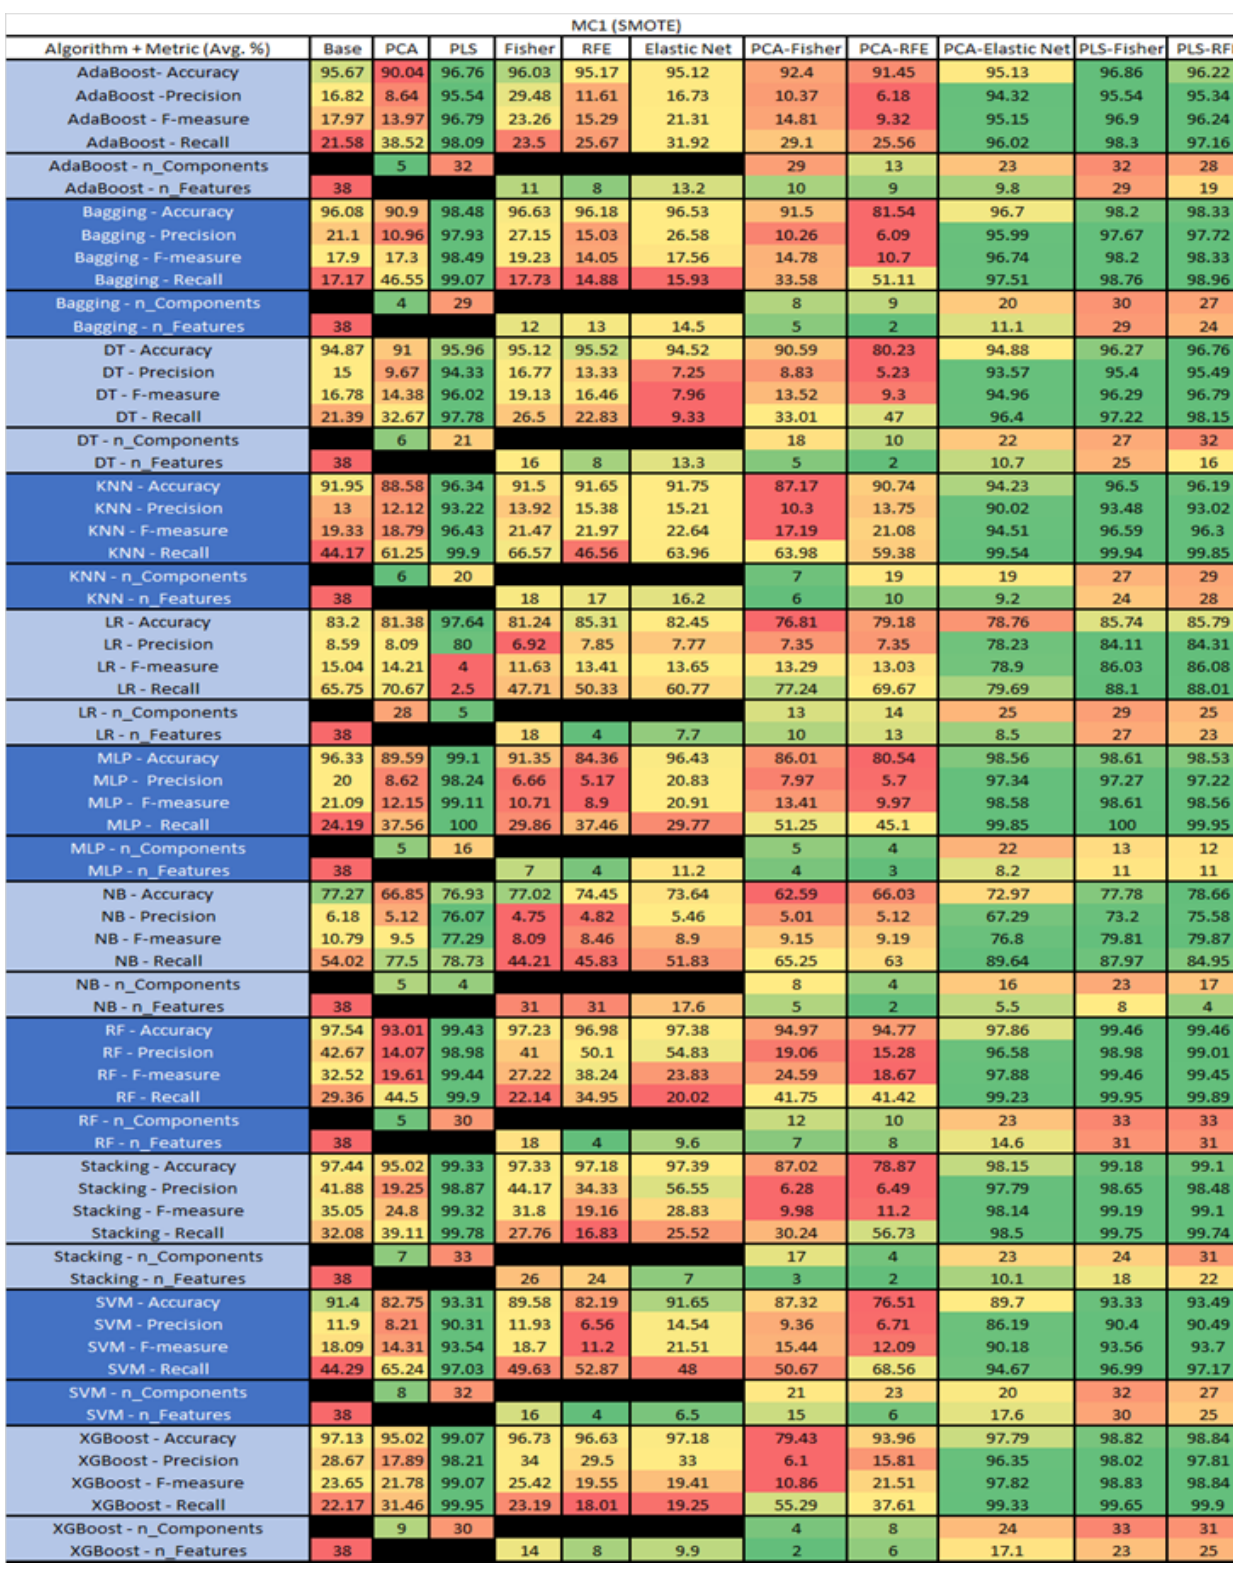
Figure 35. MC1 SMOTE NASA MDP Results Data